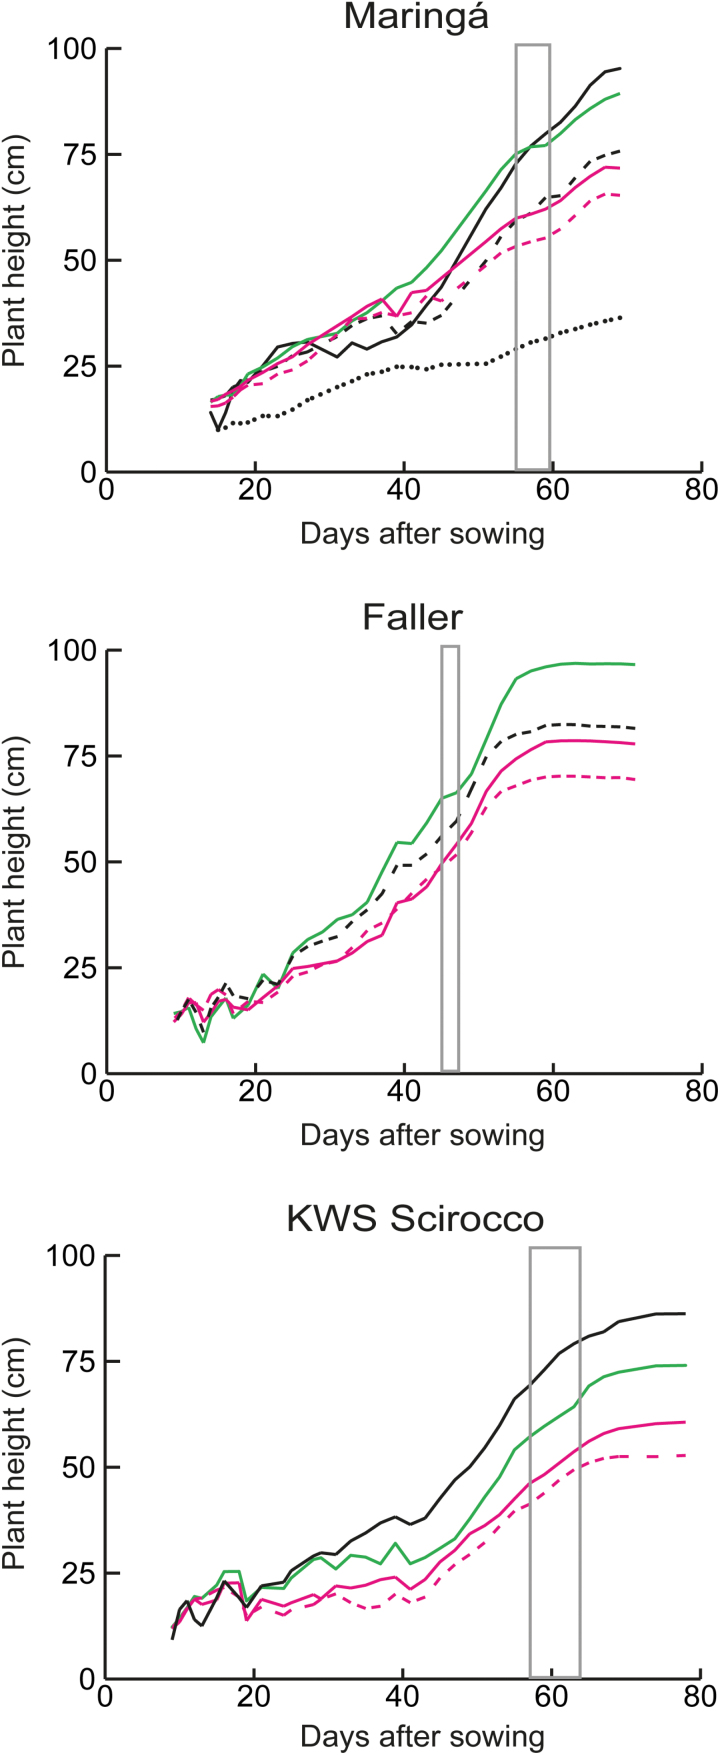

ovg alleles differentially affect plant elongation in different cultivars in the greenhouse. Plant heights are averages of at least 10 plants. The box indicates the period of first spike emergence (Zadoks 50). Black full line, Rht-B1a; black dashed line, Rht-B1b; black dotted line, Rht-B1c; full green line, Rht-B1c.22; full magenta line, Rht-B1c.26; dashed magenta line, Rht-B1c.23. Results were confirmed in two independent experiments. Representative data from the first experiment are shown.